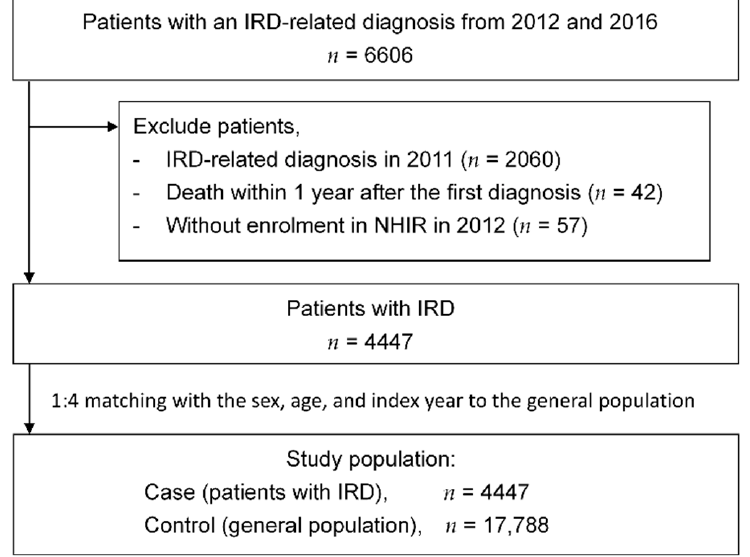
Figure 1. Patient flow diagram. Abbreviations: IRD, inherited retinal degeneration.